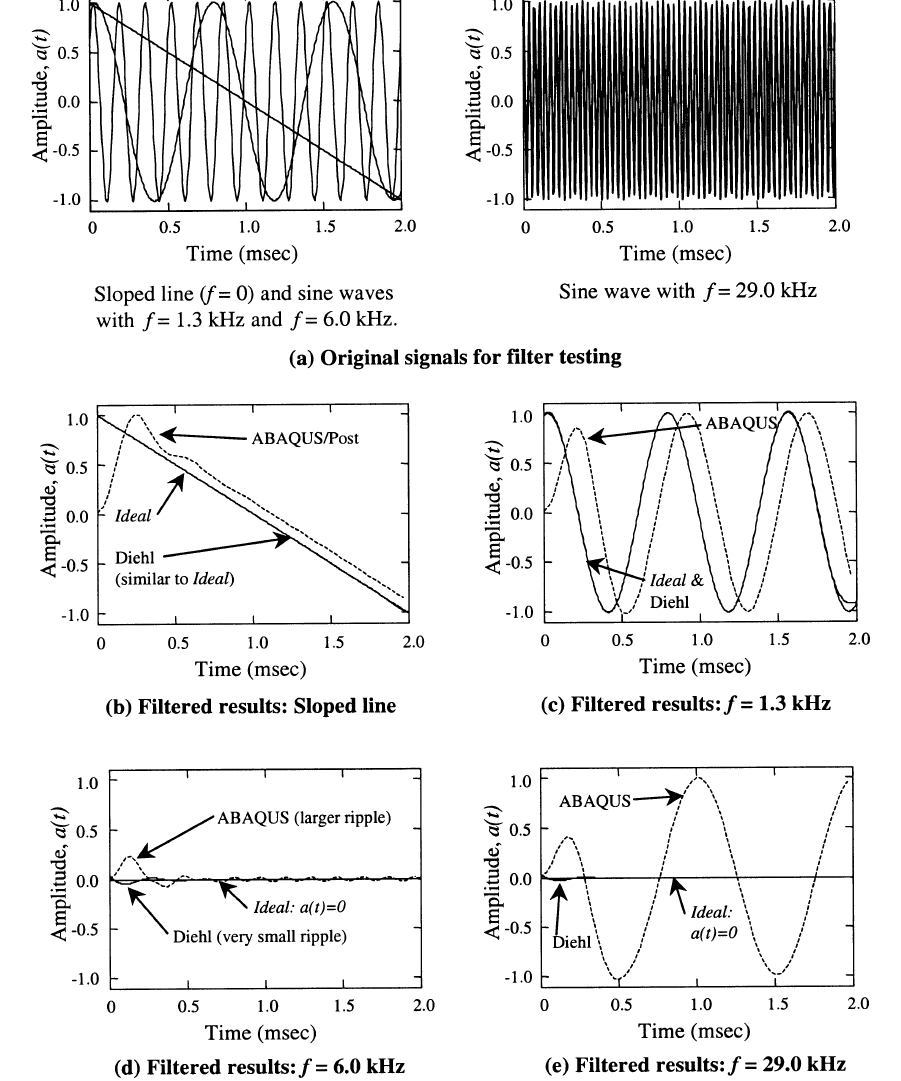
Fig. 2. Comparing ABAQUS/Post lowpass filtering and Diehl’s DSP Extensions using some digital test signals. Sample rate of all signals is 240 kHz and cut-off frequency is 3.0